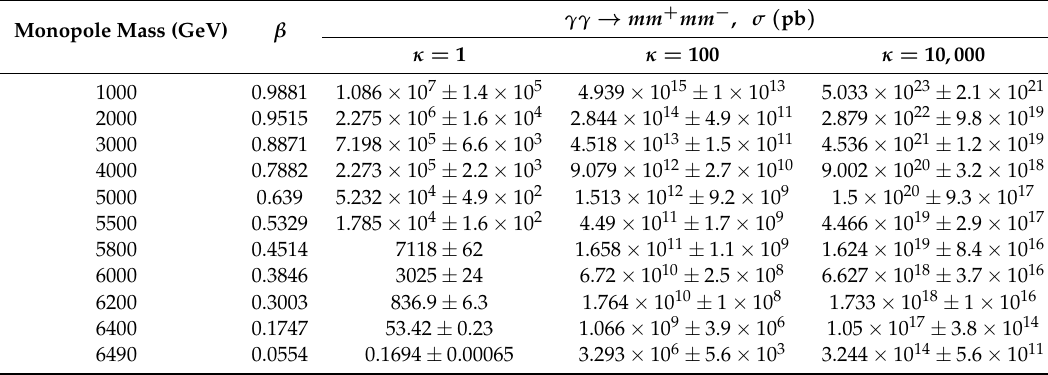
Table 8. Photon fusion production cross-sections at a photon-photon collision energy of 13 TeV for the spin 1 monopole, β -dependent coupling, and various values of the κ parameter